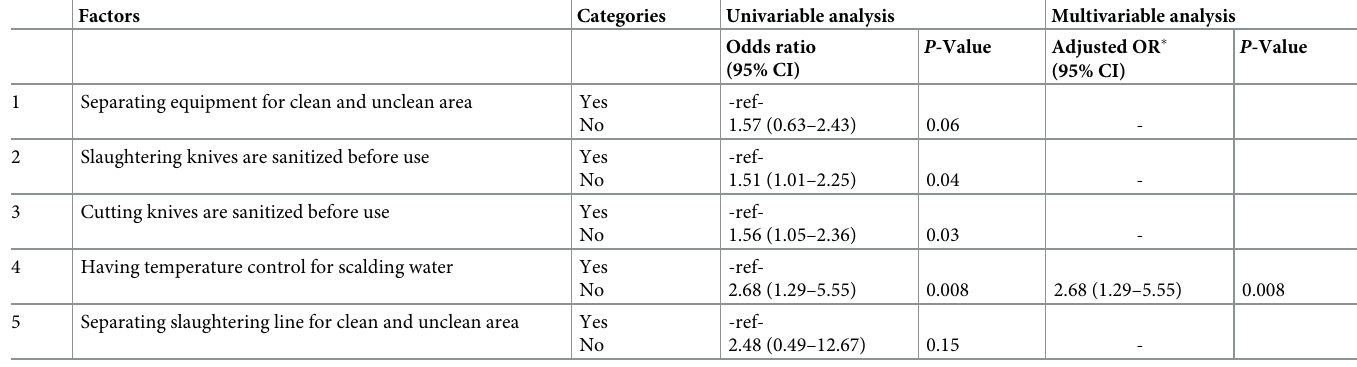
Table 3. Factors associated with the Staphylococcus aureus non-compliance of meat samples based on the univariable and multivariable mixed-effects logistic regression.